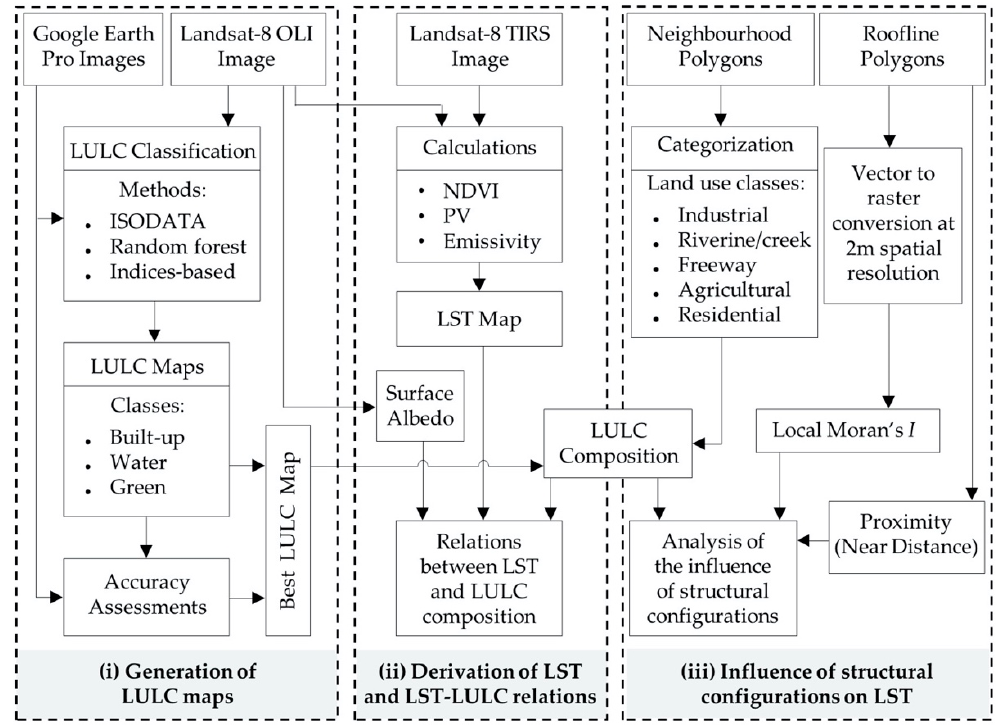
Figure 2. Schematic diagram of the proposed methods in the scope of this study.